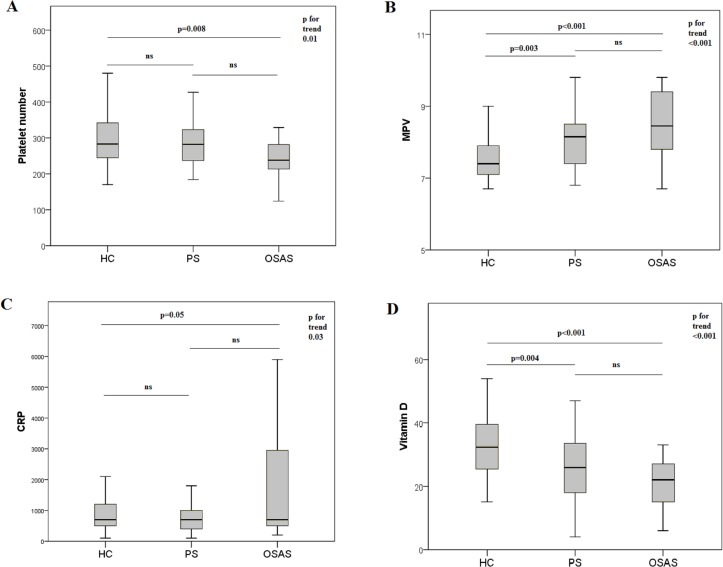
Platelet number, Mean Platelet Volume, C Reactive Protein, and Vitamin D levels in Healthy Controls, primary Snoring and Obstructive Sleep Apnea Syndrome children.(A) Platelet number (x109/L); (B) MPV(fL), Mean Platelet Volume; (C) CRP (μg/L), C Reactive Protein; (D) vitamin D (ng/ml); HC, Healthy Controls; PS, Primary Snoring children; OSAS, Obstructive Sleep Apnea Syndrome children. P values were calculated with Anova and a post hoc Bonferroni test.